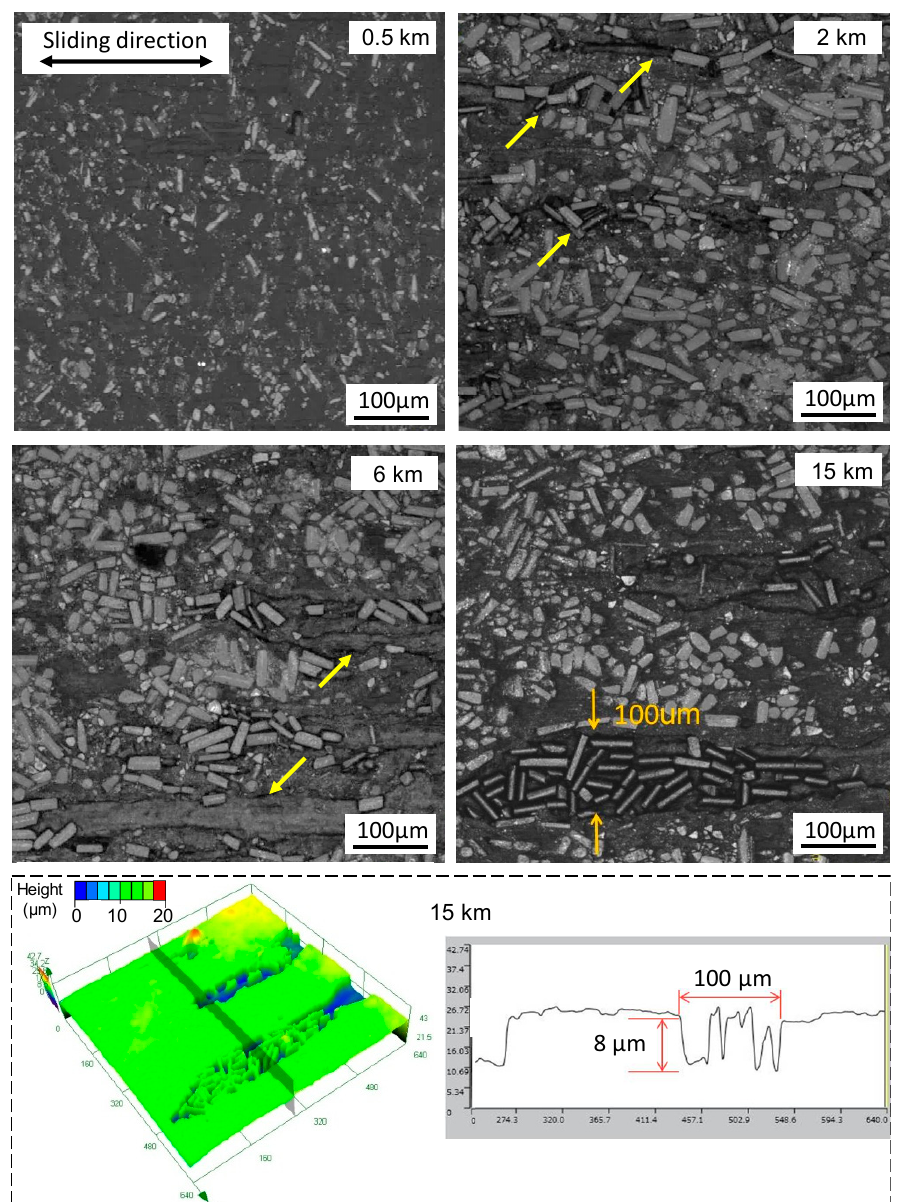
Figure 8. The wear evolution of the GFRPTFE sliding against duplex steel at 200 °C, and the 3D surface profile of the specimen after 15 km sliding.